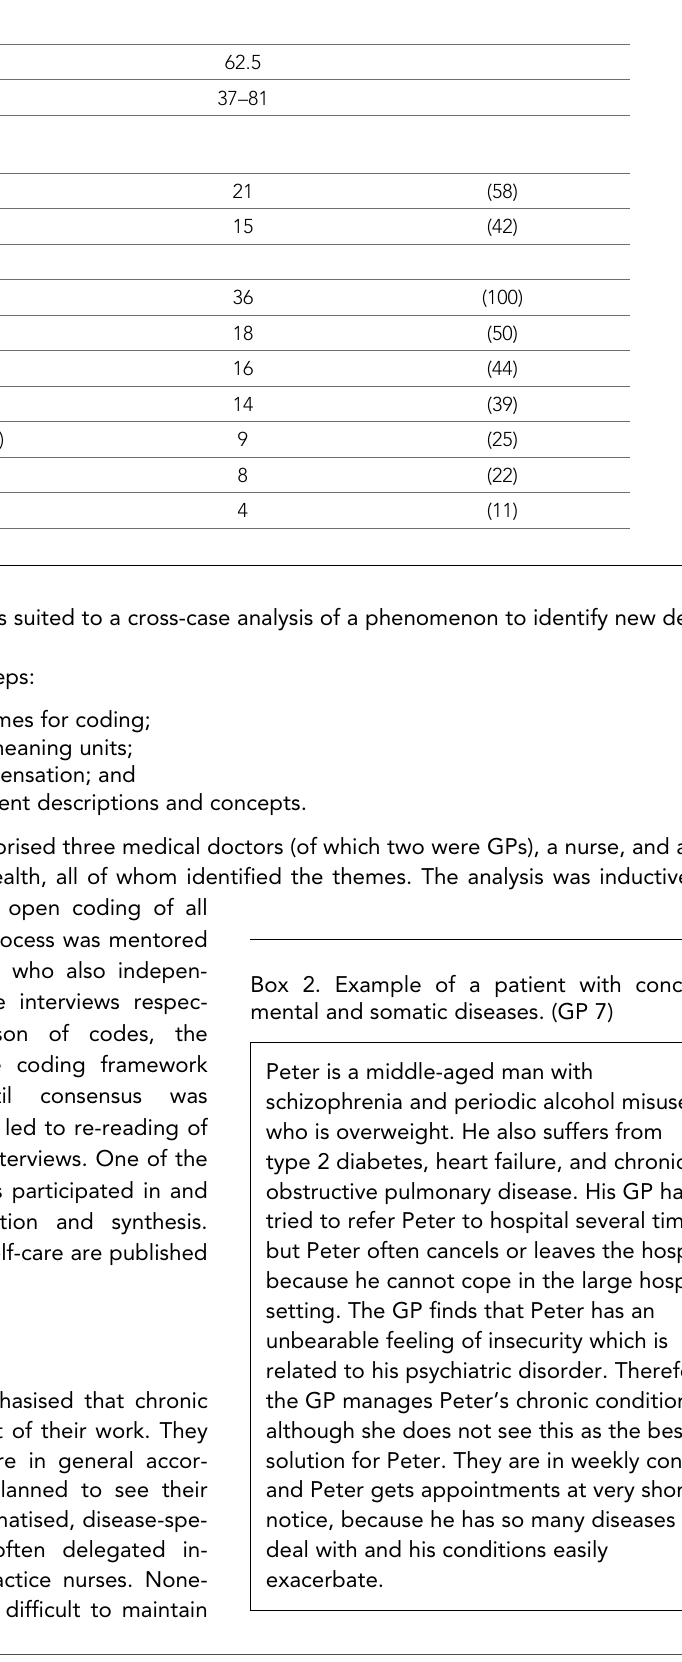
Table 3. Profile of the patient cases that informed discussion in the GP interviews, n =